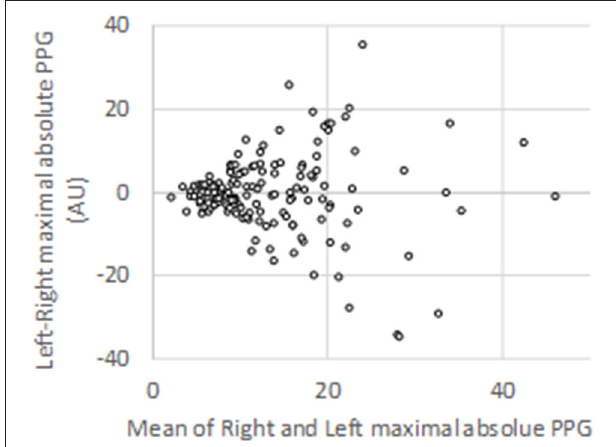
FIGURE 2 | Bland–Altman representation of the absolute peak values observed on each arm for the 151 patients studied during photo-plethysmography